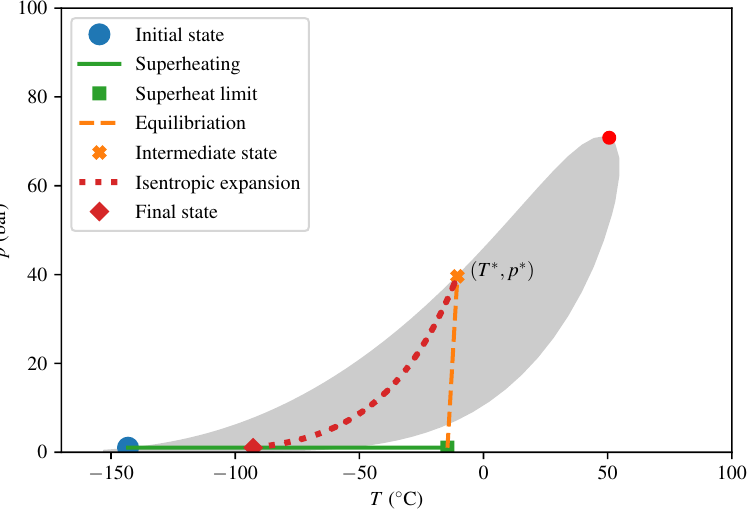
Figure 7. Thermodynamic diagram for LNG from triggering the initial (post-boil-off) state to the final state.